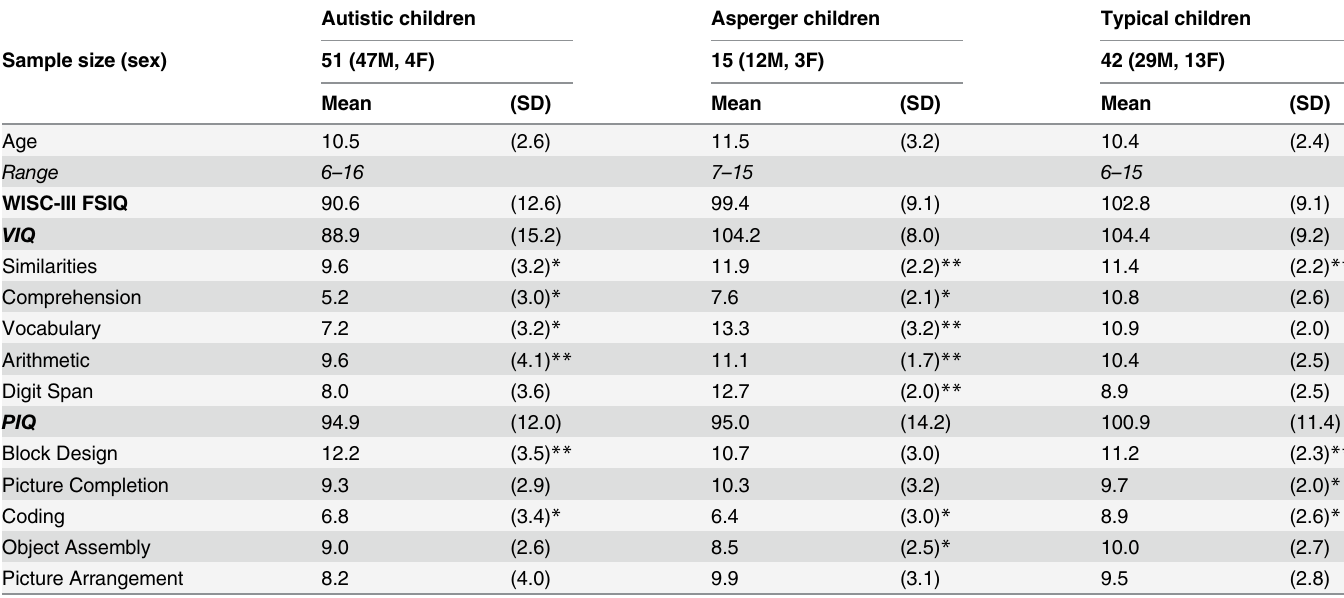
Table 1. WISC-III cognitive